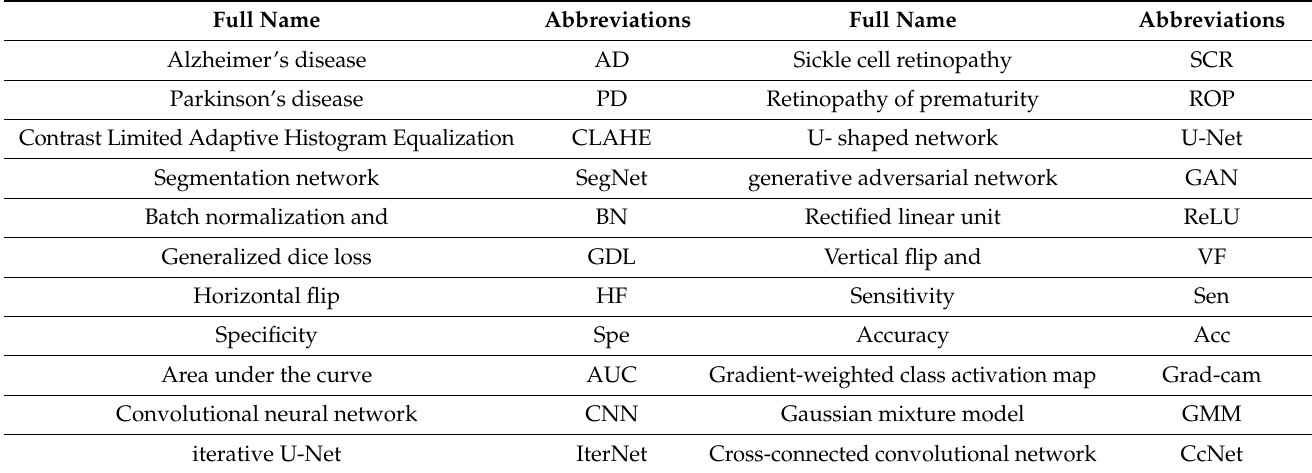
Table 1. List of